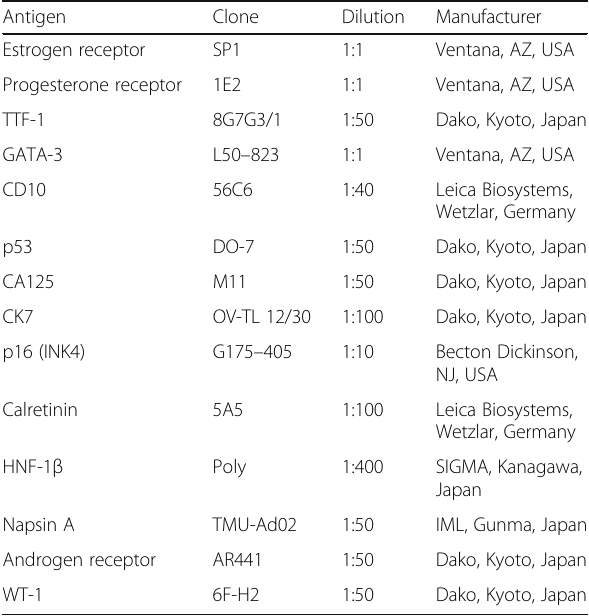
Table 1 List of antibodies